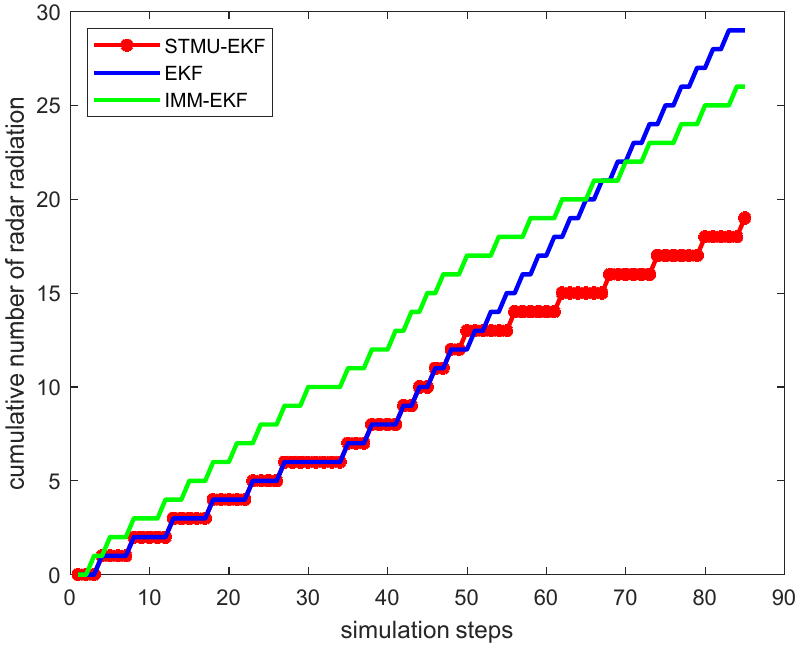
Figure 9. Radar radiation states of three algorithms.